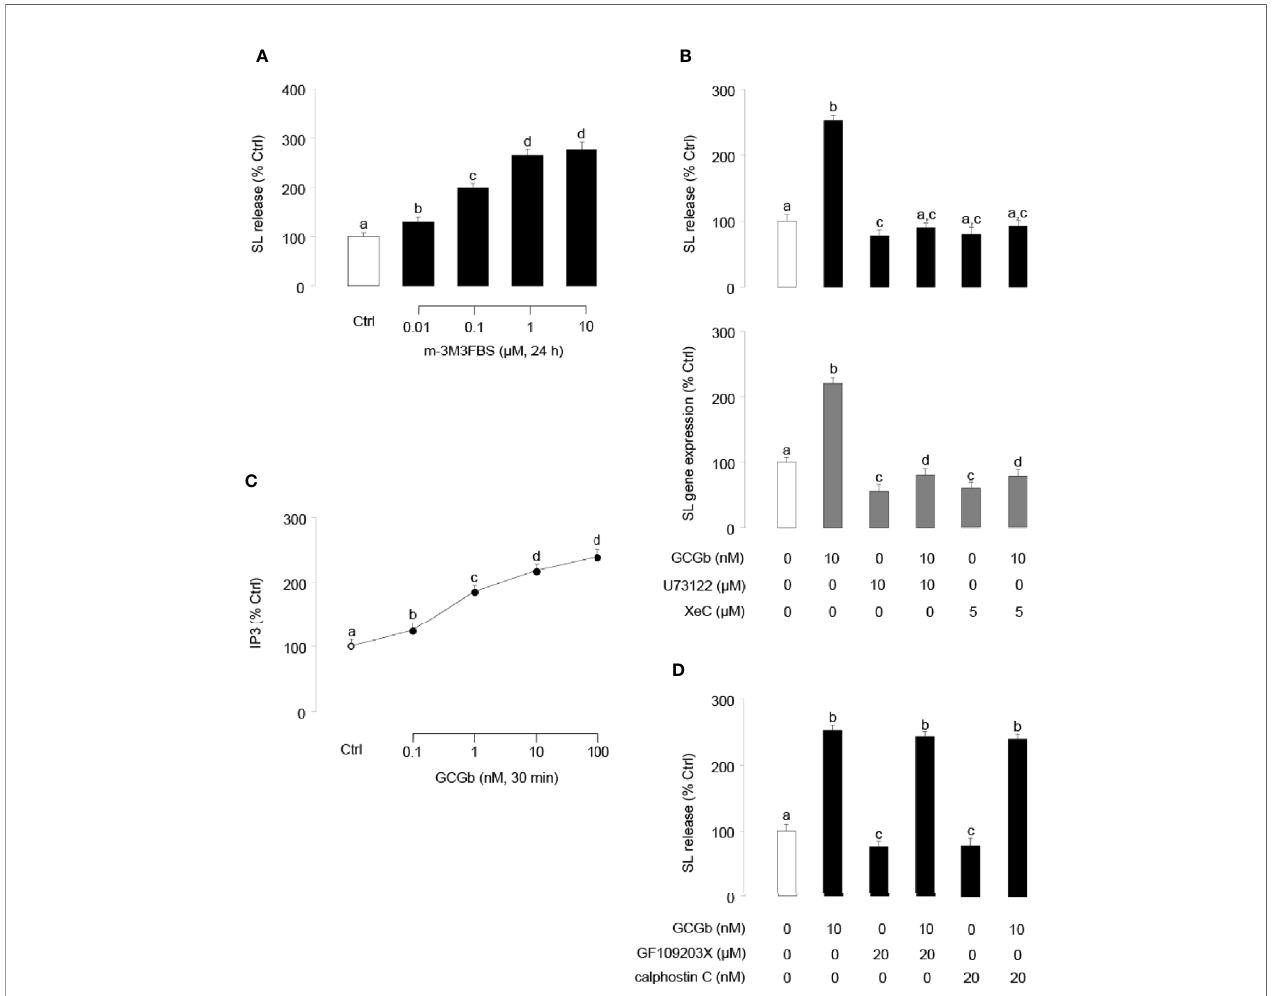
FIGURE 7 | Functional role of PLC/IP3/PKC-dependent mechanisms in SL release and gene expression. (A) Effects of increasing doses of the PLC activator m- 3M3FBS (0.01 – 10 µM) on SL release in NIL cells. (B) Effects of PLC inhibitor U73122 and IP3 receptor antagonist xestospongin C (XeC) on GCGb induction of SL release (upper panel) and gene expression (lower panel). NIL cells were exposed to GCGb (10 nM) for 24 h with or without simultaneous treatment of the PLC inhibitor U73122 (10 µM) and IP3 receptor antagonist XeC (5 µM). (C) Effects of increasing concentrations of GCGb (0.1 – 100 nM) on IP3 production in NIL cells. (D) Effects of PKC inhibition on GCGb-induced SL release. NIL cells are incubated for 24 h with GCGb (10 nM) in the presence or absence of the PKC inhibitors GF109203X (20 µM) and calphostin C (20 nM). All results are expressed as the mean ± SEM (N = 3) and different superscript letters in each column show signi fi cant differences ( P < 0.05, ANOVA followed by a Bonferroni ’ s